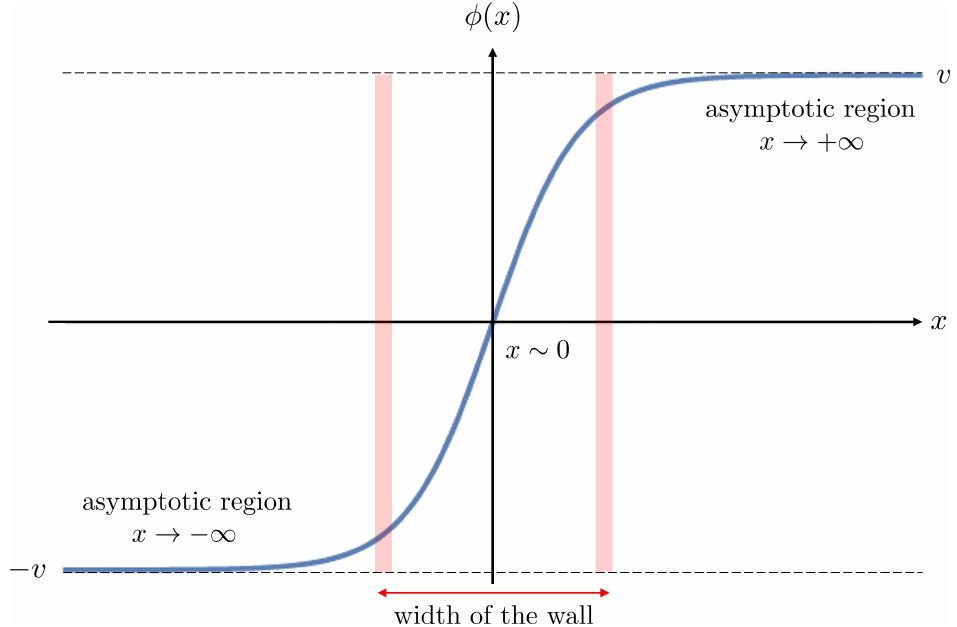
Figure 1 . Schematic illustration of the analysis made in this section to study the domain wall configuration in nonlocal field theory, whose qualitative behavior is drawn consistently with the boundary conditions φ ( ±∞ ) = ± v , and with the choice of the origin φ (0) = 0 . We analyze the behavior of the domain wall configuration in several regimes, and use different methods to find approximate analytic solutions. (i) We study the asymptotic behavior of the domain wall solution in the limit | x | → ∞ . (ii) We find a linearized nonlocal solution by perturbing around the local domain wall configuration treated as a background, and analyse its behavior not only at infinity but also close to the origin. (iii) We make an order-of-magnitude estimation for the width and the energy per unit area of the wall, and verify the consistency with the analytic approximate